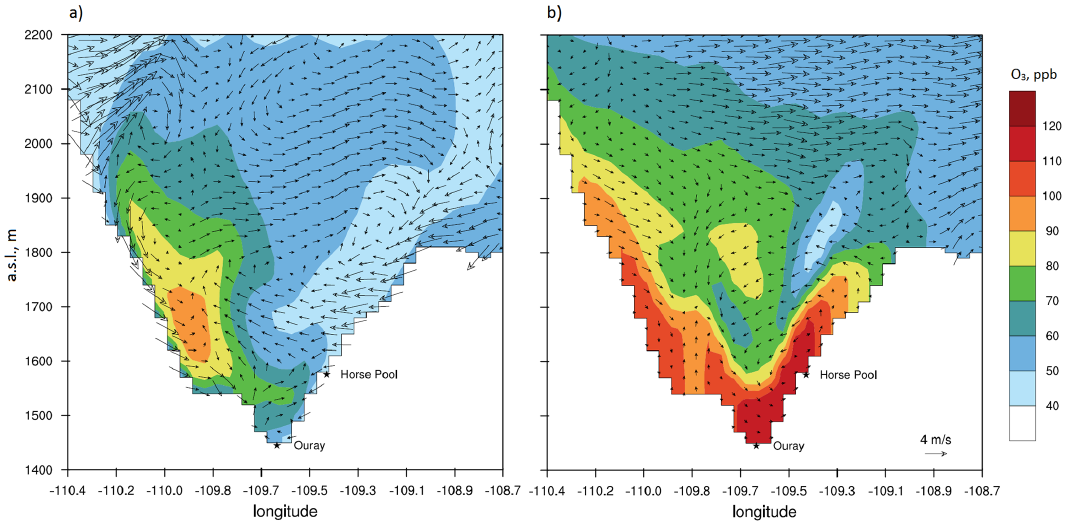
Figure 5. Simulated O 3 distribution and wind vectors over the UB (west-to-east direction in the WRF grid). The Horse Pool and Ouray surface stations along the cross section are shown; (a) early morning (05:00MST), and (b) afternoon (15:00MST) on 5 February 2013. The vertical wind components were multiplied by 100 for illustration of the wind